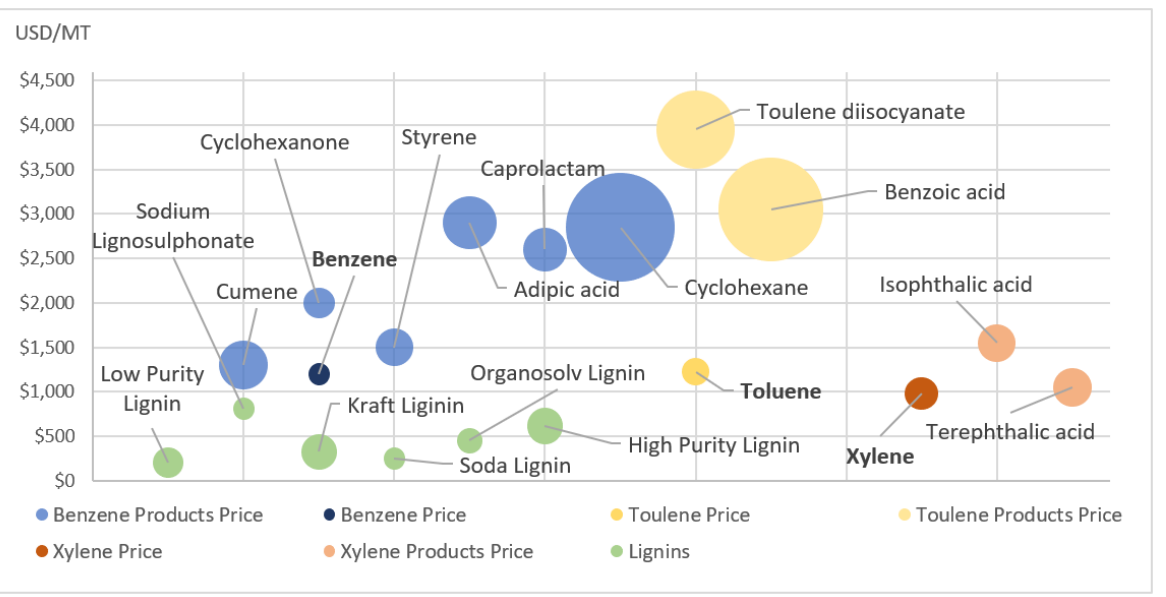
Figure 4. Lignin prices and prices of different chemicals potentially derived from lignin. Individual bubbles represent minimum and maximum price of compounds.